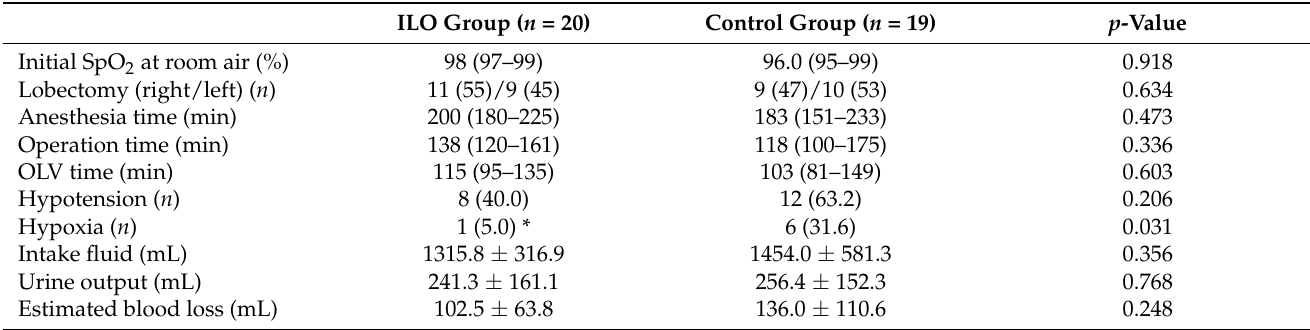
Table 2. Intraoperative